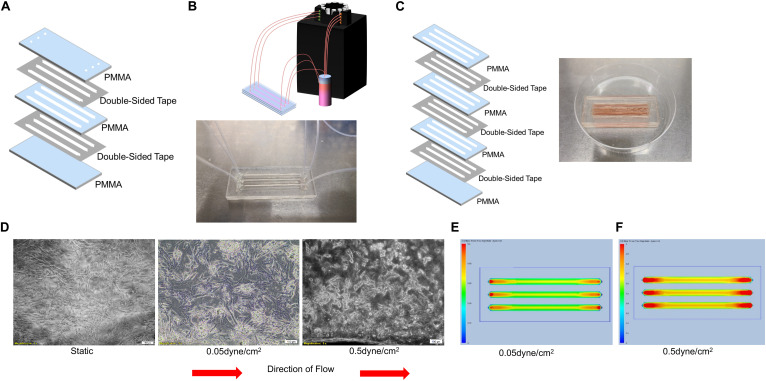
Design, Manufacturing, and Analysis of Microfluidic PMMA Devices. (A) PMMA devices were manufactured by adhering three laser-cut layers of PMMA and double-sided tape. (B) Representative image of single-use PMMA devices. These were connected to a reservoir of media and to a peristaltic pump to flow media through the devices to generate shear stresses of 0.05 or 0.5 dyne/cm2. (C) Static control devices were made by including multiple thicker channel layers to form a deep well to hold the same amount of media. Representative image of single-use static control PMMA devices. (D) Bright field images (5X magnification) of PLC in either static (left) or flow conditions (center and right). After PLC experienced shear stress of 0.05 dyne/cm2 for 24 h, they exhibited flow-induced changes in shape (center) with further changes in morphology seen after PLC experienced the higher shear stress of 0.5 dyne/cm2 for 24 h (right). (E) Computational fluid dynamics analysis showing shear stress maps at the base of the of channels, demonstrating that shear levels ranged from 0.05 dyne/cm2 at the edges to a slightly elevated shear stress of 0.06 dyne/cm2 in the center of the channel. (F) Computational fluid dynamics analysis showing shear stress maps at the base of the channels, demonstrating that the shear stress at the edges of the channel was 0.5 dyne/cm2, with a gradual increase to 0.7 dyne/cm2 in the center of the channel.